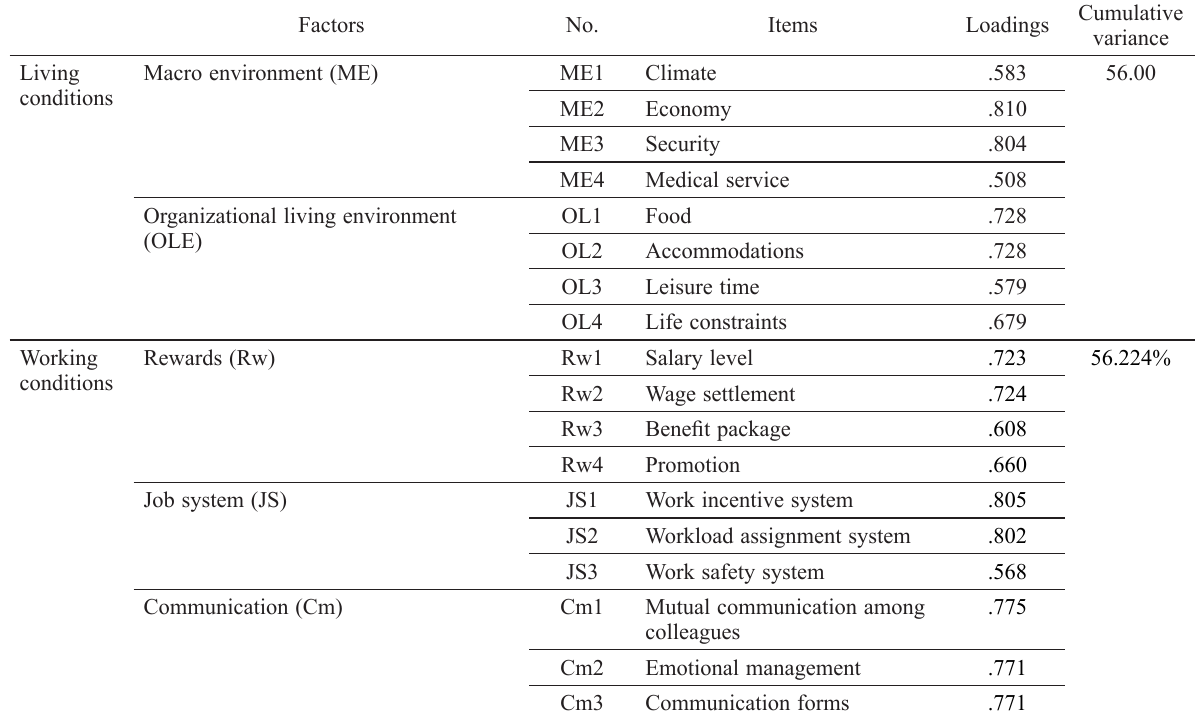
Cumulative variance